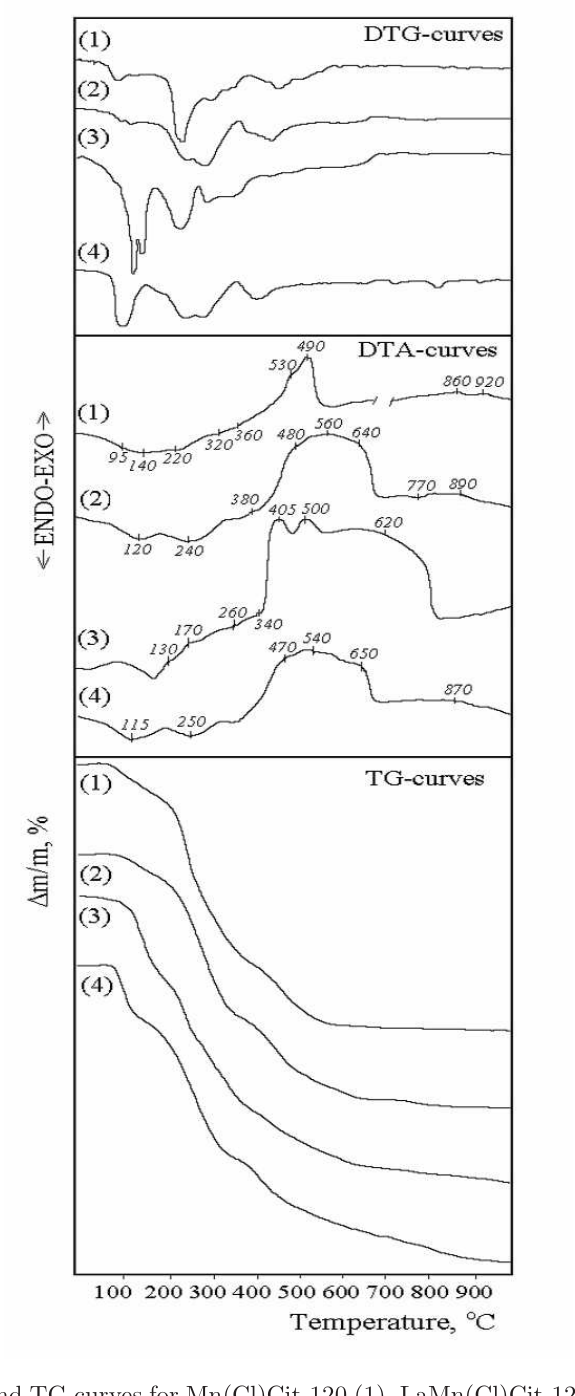
Fig. 4 DTA, DTG and TG curves for Mn(Cl)Cit-120 (1), LaMn(Cl)Cit-120 (2), LaMn(N)Cit-80 (3) and LaCaMn(Cl)Cit-120 (4). For the symbol meaning see Table 1,